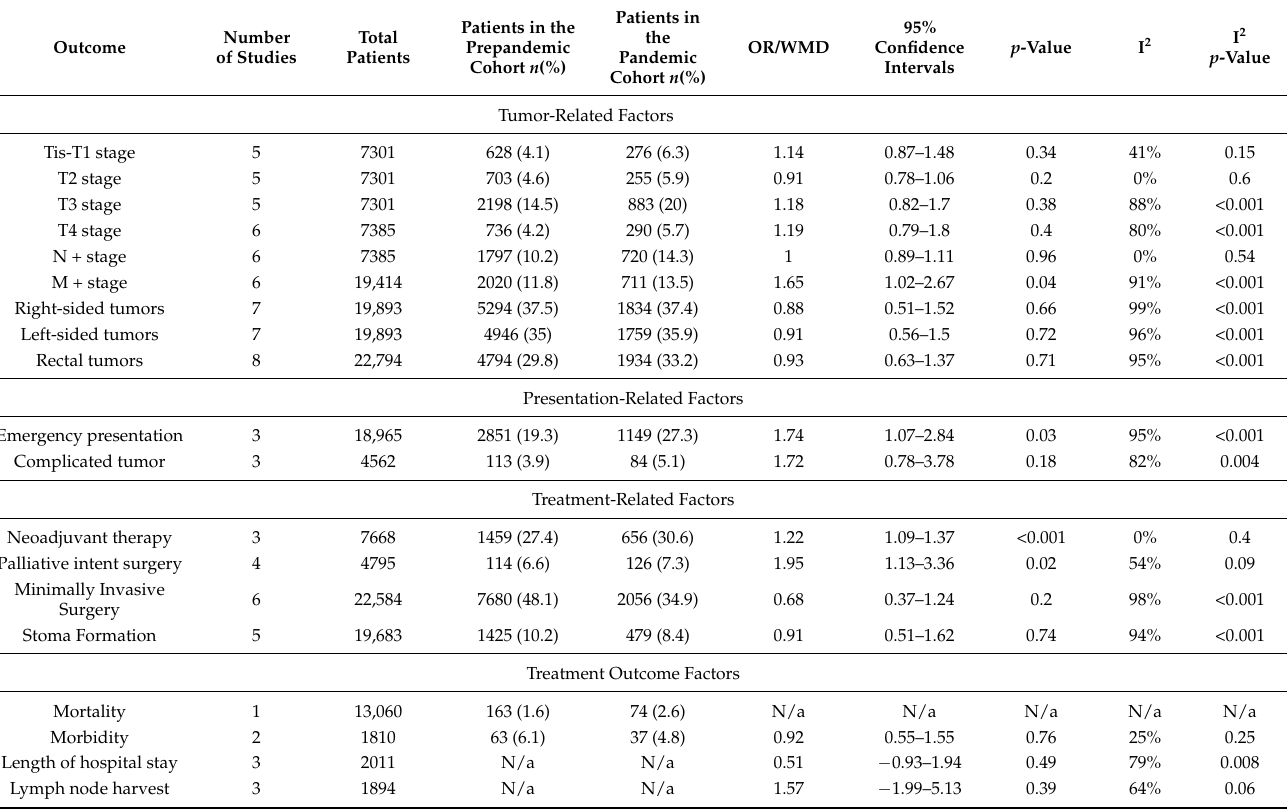
Table 2. Pooled analysis